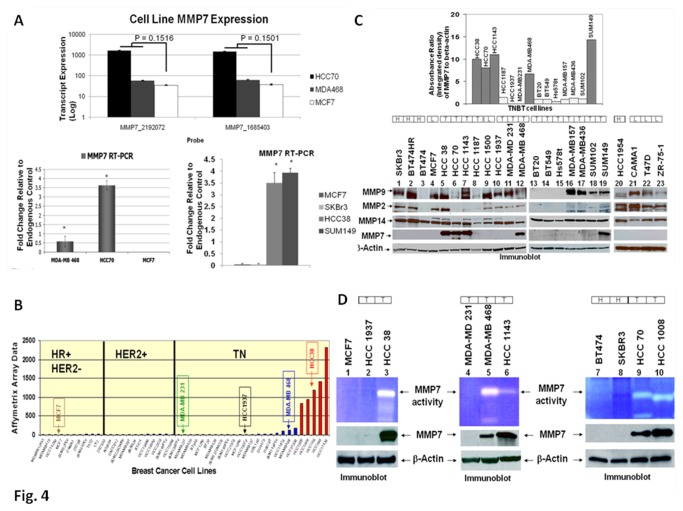
Expression of mRNA, protein and enzymatic activity of MMP7 in TNBC cell lines as compared to HER2+ and luminal BC cell lines.(A) Bar diagram (upper panel) shows mRNA expressions for MMP7 in HCC70 (black), MDA-MB468 (grey), and MCF7 (white) BT-like cell lines. Error bars represent one standard error of the mean and p-values are determined using a t-test for unequal sample sizes and means. Bar diagram in the lower panel (left) shows the validation of the expression of mRNA for MMP7 by RT-PCR in the BT cell lines. Expression of MMP7 measured by RT-PCR is concordant with microarray data for the HCC70, MDA-MB-468, and MCF7 cell lines. Expression is determined by the average of three replicates and bars represent one standard error of the mean (*p < 0.05). Bar diagram in the lower panel (right) shows RT-PCR expression of mRNA for MMP7 in different BT cell lines (MCF7, SKBr3, HCC38, SUM149). Values represent the mean of three replicates, and error bars represent one standard error of the mean (*p < 0.05). (B) MMP7 mRNA expression was upregulated in only a subset of TN breast cancer cell lines (shown in red) and not in any other types of BC-like cell lines. MMP7 affymatrix expression data from Neve et al. [36], grouped by hormone receptor and HER2 status. (C) Immunoblots showing differential expression of MMP7 protein (lanes 5-7, 12, 13, 14–16, 18-19) in TN breast cancer (T) cell lines as compared to HER2+ (H) and luminal (L) BC-like cell lines. Levels of MMPs 2, 9 and 14 are determined as references. Inset shows a differential expression of expression of MMP7 protein in a subset of TN breast cancer cell lines as determined by densitometry semi-quantitative analyses (imageJ program; absorbance ratio of MMP7 to beta-actin) of respective immunoblots. (D) Caesin-zymogram of the secreted-MMP7 and corresponding immunoblots of the cellular-MMP7 protein levels show both an increased expression and enzymatic activity of MMP7 (lanes 3, 5, 6, 9, 10) in TN breast cancer cell line (T) as compared to HER2+ (H) and luminal (L)-like cell lines.